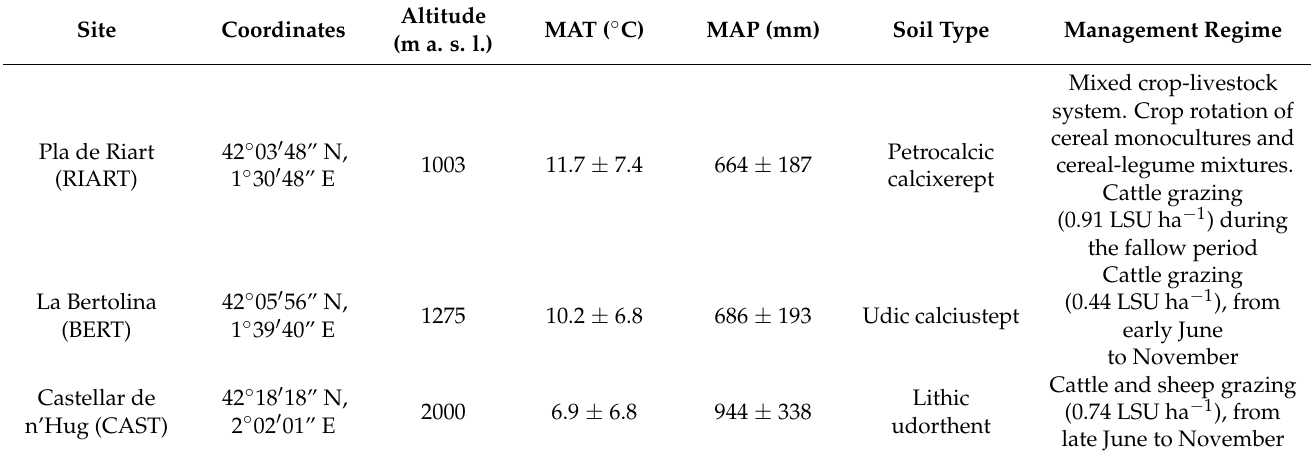
Figure 3. ( A ) Mean annual temperatures (T a, dots) along time, linear relationship and 95% confidence interval and ( B ) temperature difference compared to the average in the period 2012–2020. Data source: eddy covariance flux stations. Table 1. Site names, coordinates, altitude, mean annual temperature (MAT), source: eddy covariance flux stations, data from the period 2012–2020; mean annual precipitation (MAP), source: Servei Mete- orologic de Catalunya (https://en.meteocat.gencat.cat/, accessed on 14 August 2022, see the details in Annex S2); soil type according to the NRCS/USDA nomenclature [24]; and management